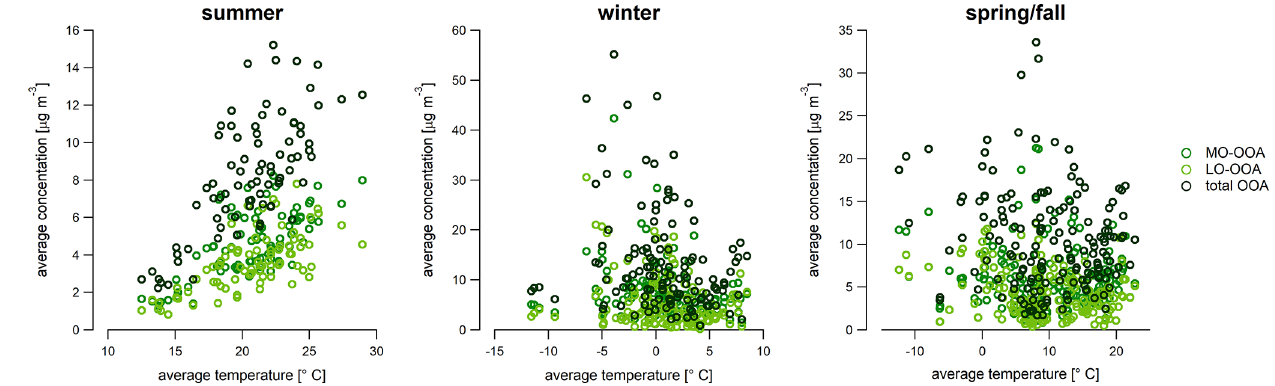
Figure 6. Daily average concentrations of the OOA factors versus the daily average temperature for summer, winter, and spring and